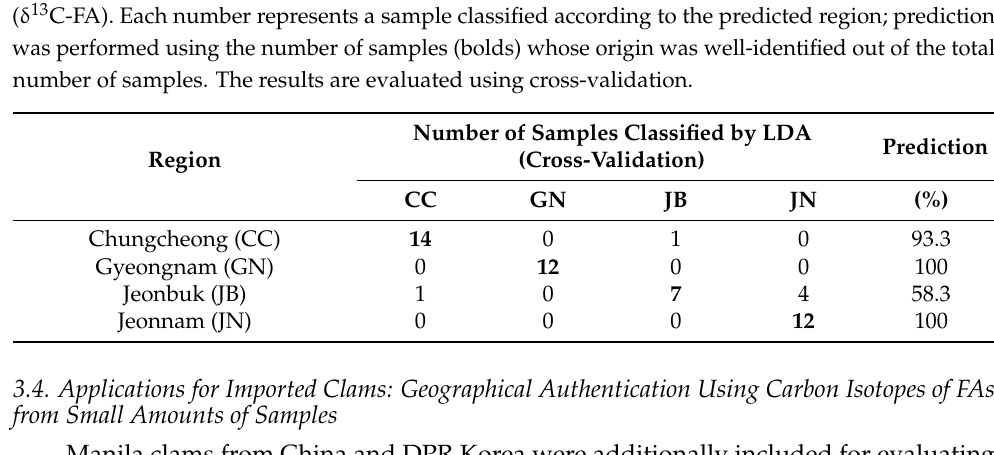
Table 5. Predicted geographical origins of clams from different provinces of Korea. Numbers of individual clams with geographical origins determined by LDA of carbon isotope ratios of fatty acids ( δ 13 C-FA). Each number represents a sample classified according to the predicted region; prediction was performed using the number of samples (bolds) whose origin was well-identified out of the total number of samples. The results are evaluated using cross-validation.